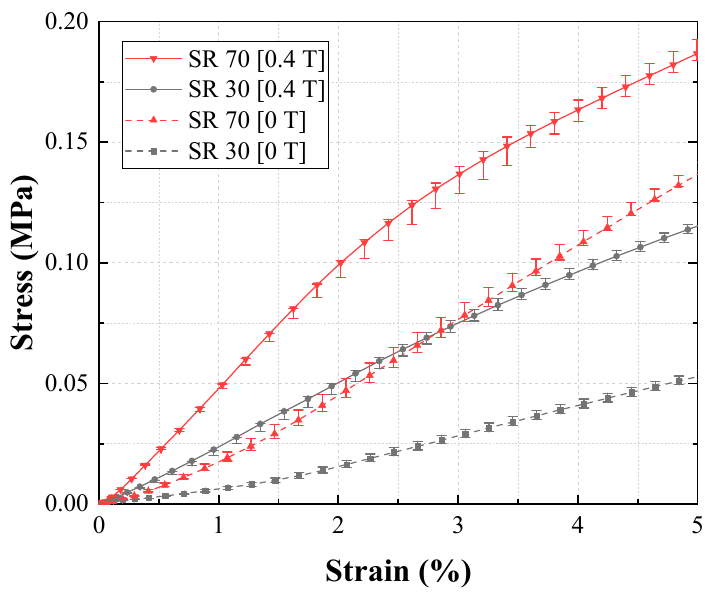
Figure 9. E ff ect of the shore hardness of the MRE layers on Young’s modulus. Figure 9. Effect of the shore hardness of the MRE layers on Young’s modulus. Figure 9. Effect of the shore hardness of the MRE layers on Young’s modulus.